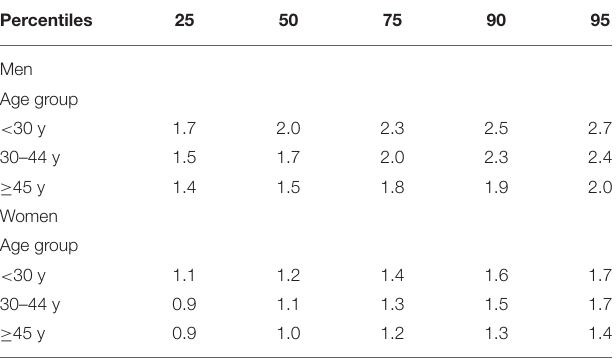
TABLE 2 | Percentile values of relative handgrip strength (kg/kg/m 2 ) by sex and